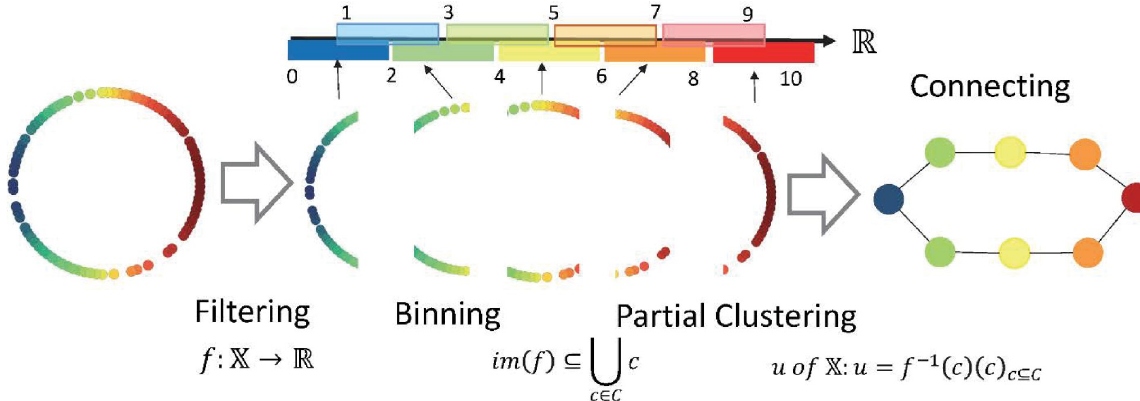
Fig 2. Topological data analysis mapper process. The filtering parameters are as follows: range = 0–10; interval length = 2; intervals = 5; overlap = 50%.